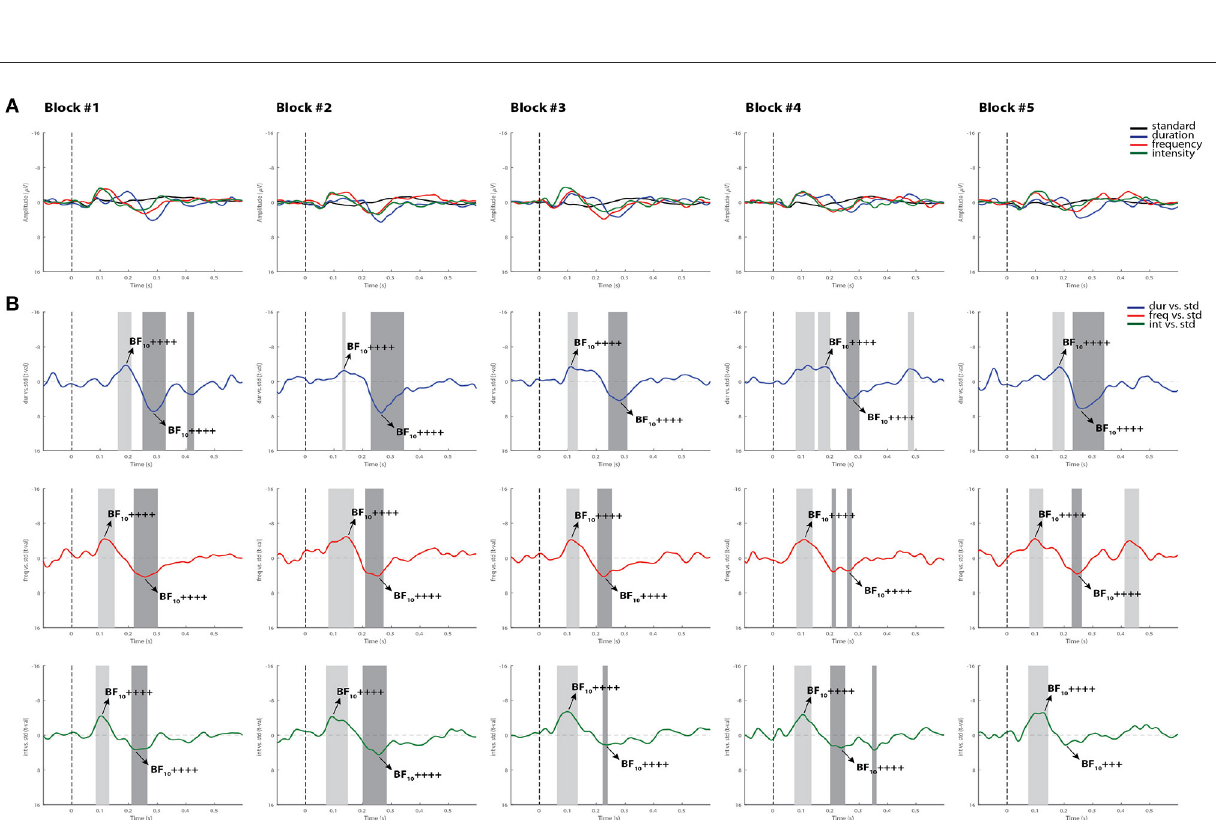
FIGURE4 Individual ERPs and statistical findings of a representative control subject with the highest MMN detection rate. (A) Individual ERPs across blocks. (B) Time course of the difference between deviants and standard stimuli expressed in units of t -values. Significant intervals for negative components are denoted by a light gray area, and those for positive components are denoted by a dark gray area. Black arrows show the latency of maximum Bayes factors and the strength of evidence for H 1: +, anecdotal; ++, moderate; +++, strong; ++++, very strong to